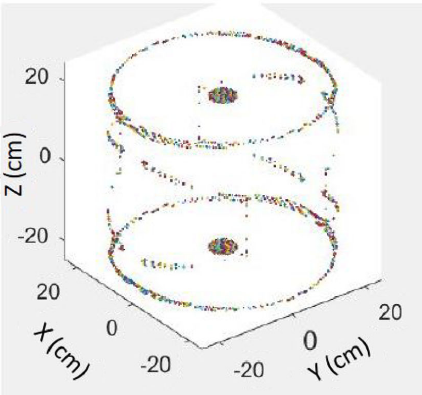
FIG. 24. Different types of primary particle source for the multipacting simulations: (a) particle volume source, and (b) whole cavity surface as a particle source.